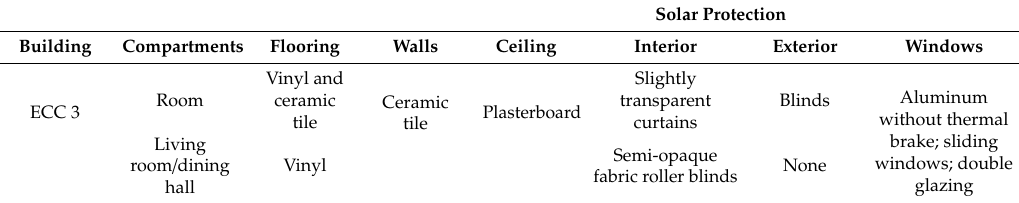
Table 4. Covilh ã : interior cladding, windows, and solar protection in the various compartments.